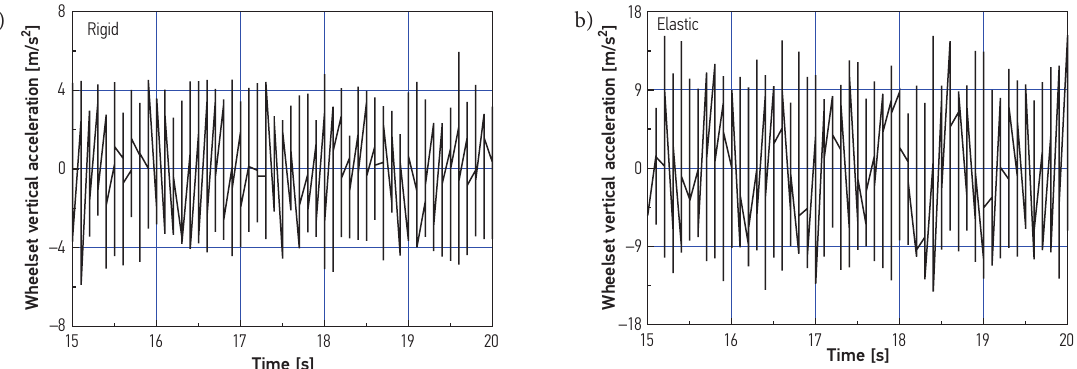
Time [s] Fig. 5. Time history of wheelset vertical accelerations as a function of rigid and elastic model: a – rigid; b – elastic